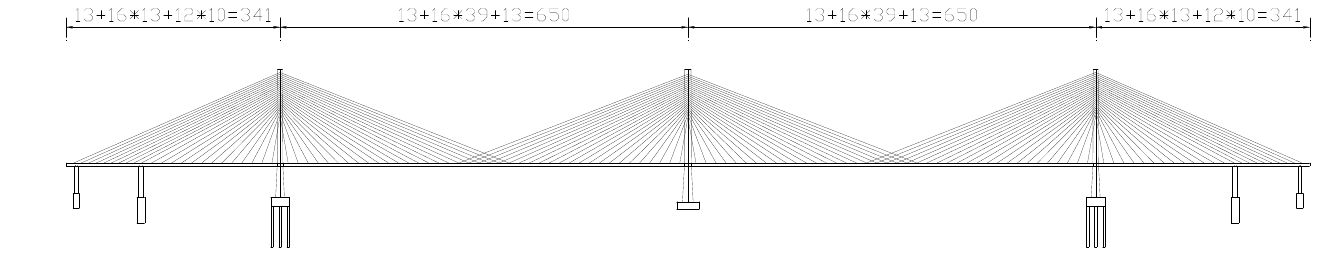
Figure 1. Elevation of structure (m).